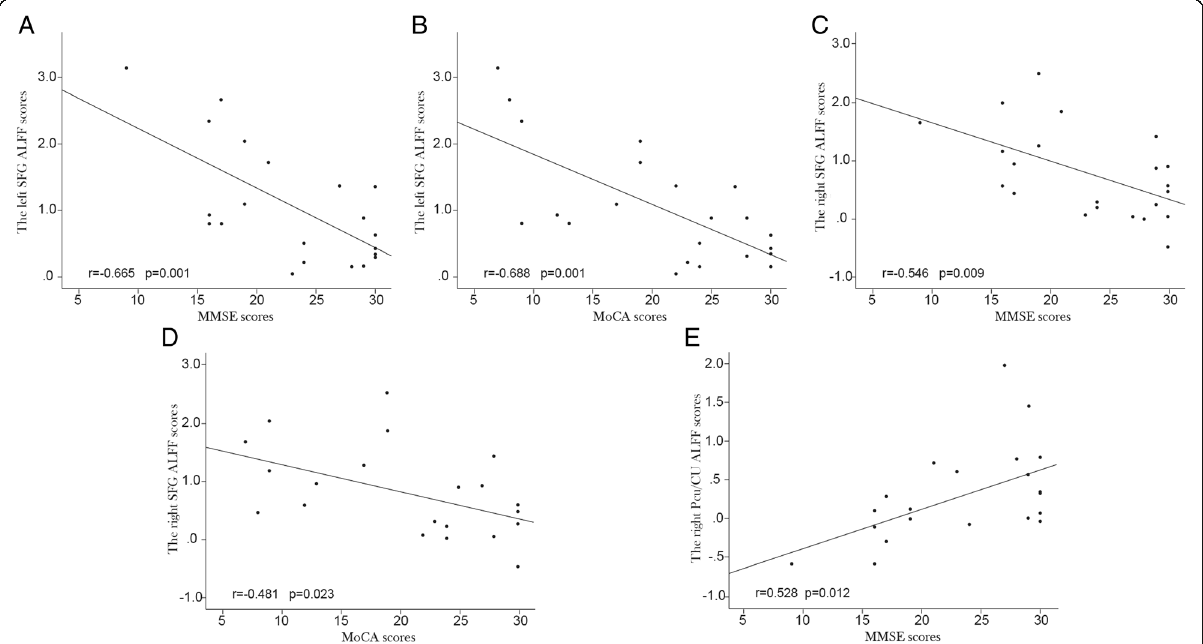
Fig. 3 Significant correlations between the individual mean ALFF z-scores and cognitive measures for the surviving clusters in the CADASIL group. a The left SFG and MMSE; r = − 0.665, n =22, p =0.001. b The left SFG and MoCA; r = − 0.688, n =22, p =0.000. c The right SFG and MMSE; r = − 0.546, n =22, p =0.009. d The right SFG and MoCA; r = − 0.481, n =22, p =0.023. e The right Pcu/CU and MMSE; r =0.528, n =22, p =0.012. ALFF: amplitude of low- frequency fluctuation; CADASIL: cerebral autosomal dominant arteriopathy with subcortical infarcts and leukoencephalopathy; SFG: superior frontal gyrus; MMSE: Mini-Mental State Examination; MoCA: Montreal Cognitive Assessment; Pcu/CU: precuneus and